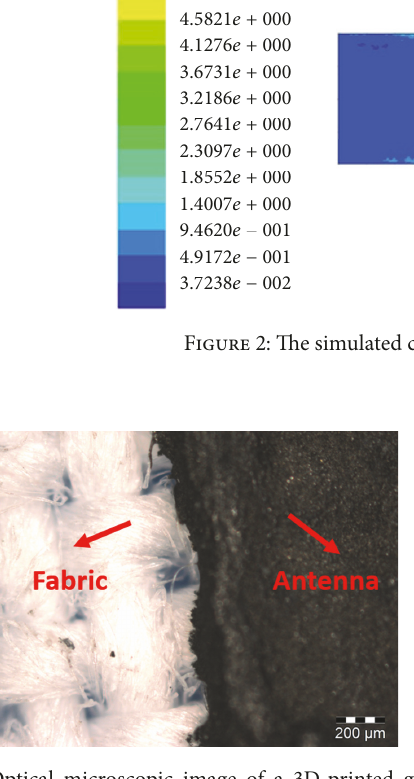
Figure 3: Optical microscopic image of a 3D-printed graphene antenna on cotton (magnification ×